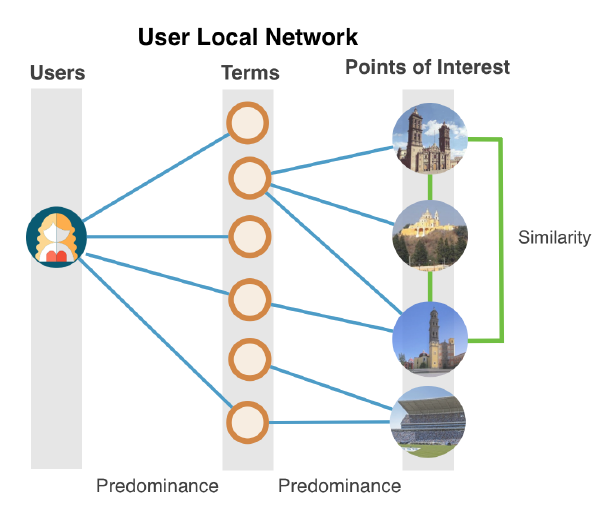
Figure 3: User Local